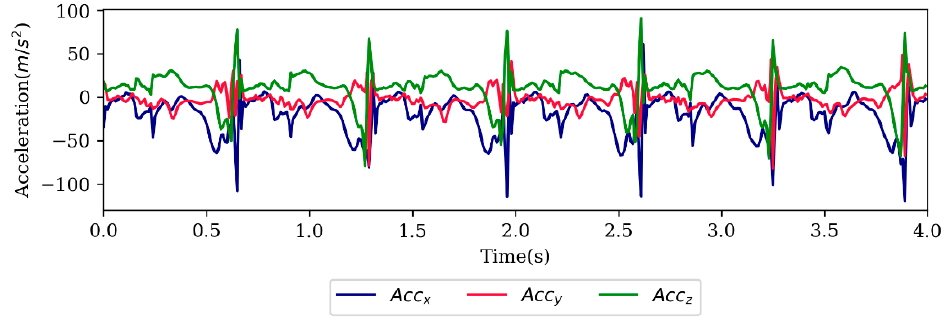
Figure 2. Sample of raw accelerometer signal.